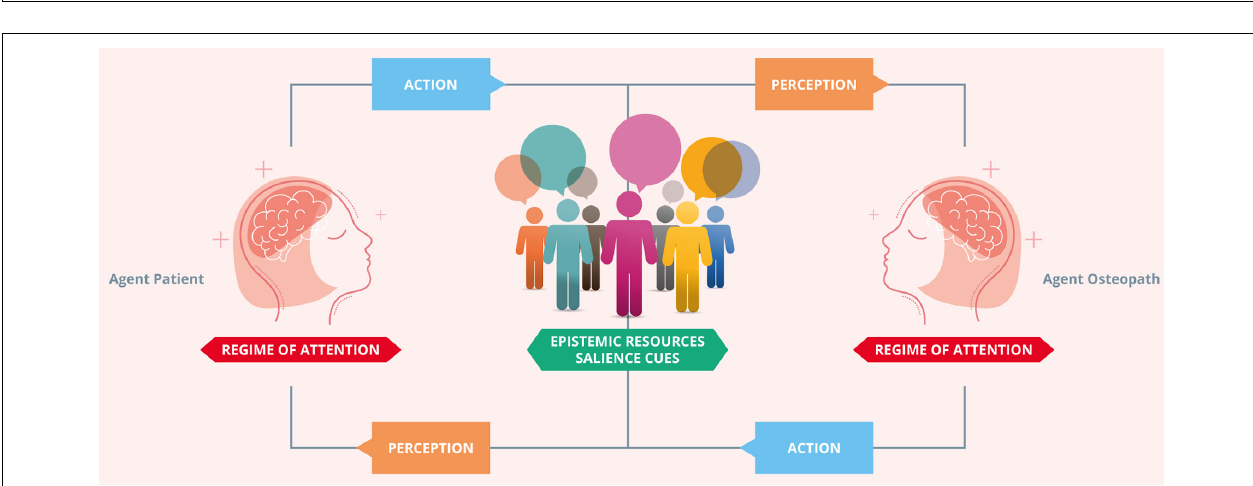
FIGURE 3 | Thinking through other minds. The agent osteopath and the agent patient build shared expectations through engagement with the clinical encounter social and material affordances, allowing adaptive niche construction by thinking through other minds. In the context of communication in clinical practice, coupled dynamics are strengthened by an adaptive prior for alignment. The adaptive prior for alignment specifies the characteristically enhanced precision of the hypothesis that “we” exist. This prior motivates similar agents to actively couple their respective actions and perceptions. The coupling of perception and action enables the osteopath and patient to reliably align with (i.e., infer) the hidden states of the other. This circular process brings about a process of cultural niche construction that creates, maintains, and modifies a set of predictable epistemic resources. These specify a set of high value (i.e., predictable) observation-policy mappings, which are used to disambiguate the mental states of conspecifics. Effective communication plays a crucial role in enabling agents with an adaptive prior for alignment to effectively disambiguate external states. An agent’s external states are constituted, in part, by the internal, mental states of another agent (and vice versa). This follows from the fact that external states cause sensation; for an agent equipped with an adaptive prior for alignment, inferring external states entails inferring other agents’ hidden states. Adapted with permission from Vasil et al. (2020).